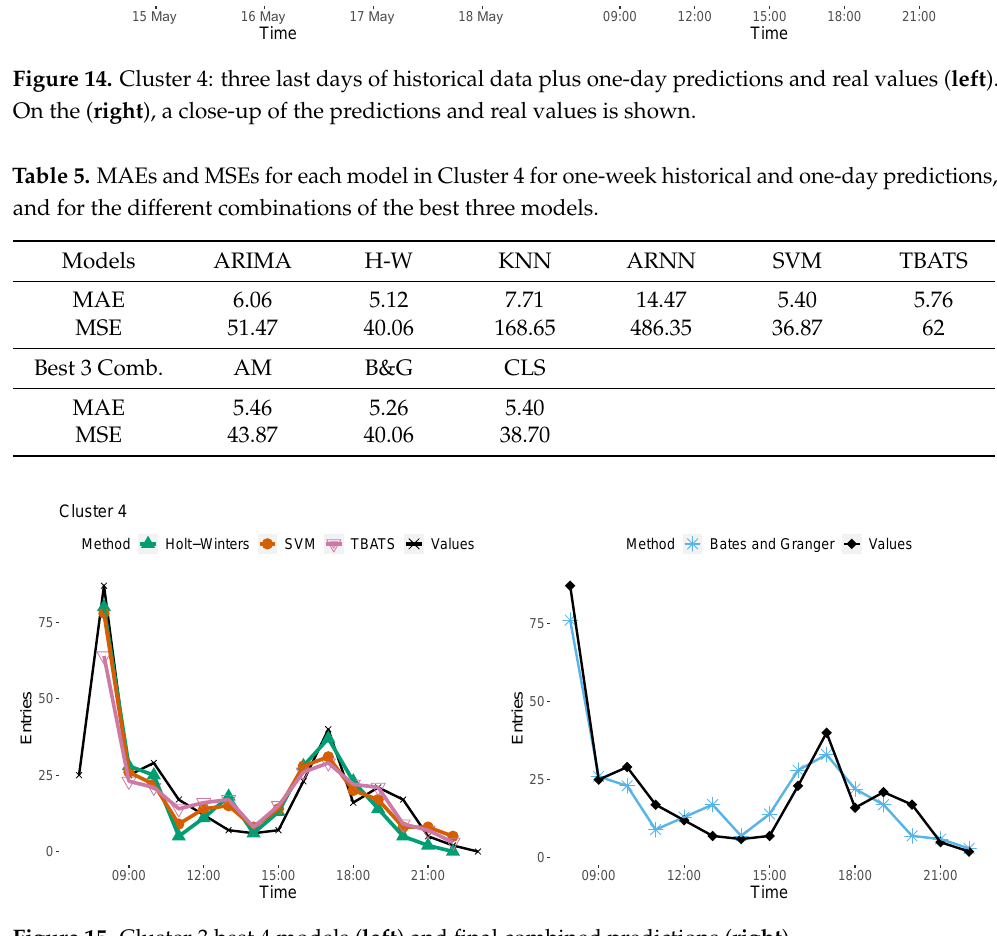
Figure 15. Cluster 3 best 4 models ( left ) and final combined predictions ( right